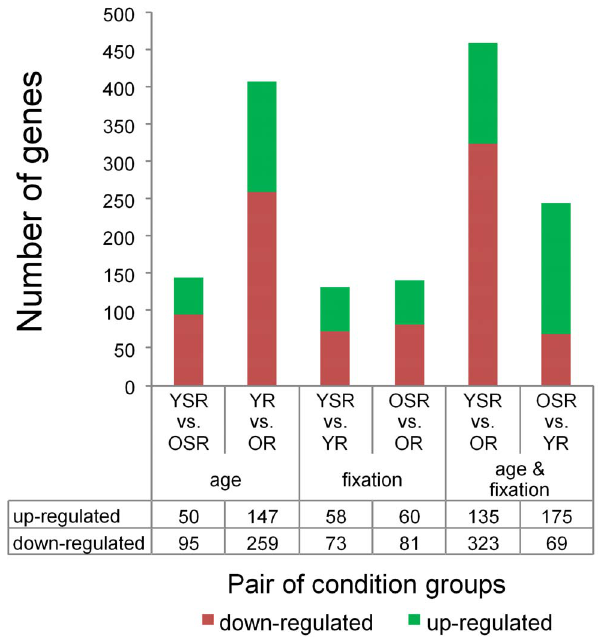
Protein Gene Primer Sequence (forward/reverse)